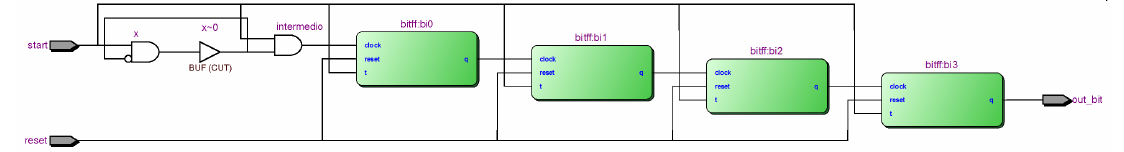
Figure 4. NANDT Oscillator